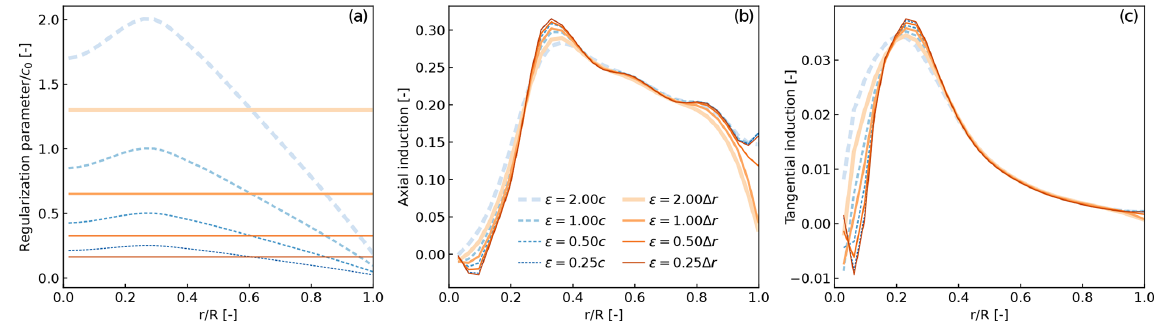
Figure 4. Influence of the regularization parameter on the induction factors obtained along a wind turbine blade. (a) Regularization parameter normalized by maximum chord. (b) Axial induction. (c) Tangential induction.